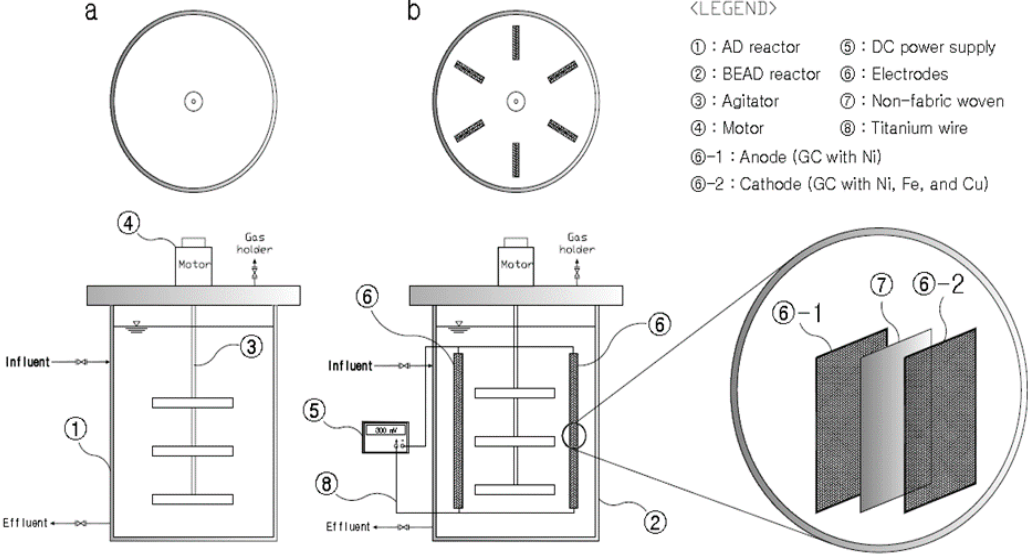
Figure 1. Detailed configuration of anaerobic digestion (AD) ( a ) and bio-electrochemical anaerobic digestion (BEAD) ( b ) reactors.